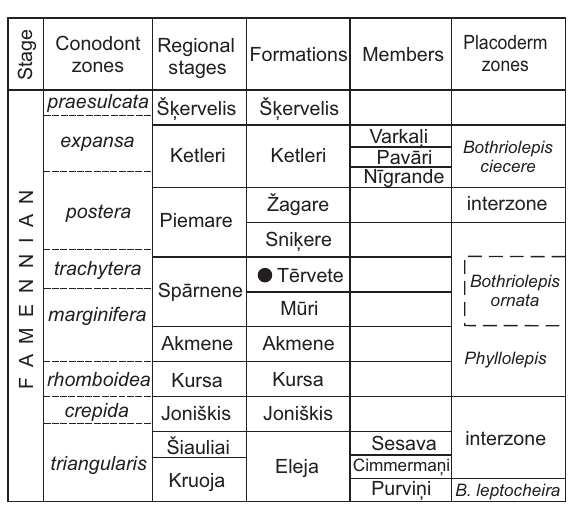
Fig. 2. Stratigraphic chart of the Famennian deposits of Latvia. Modified from Lukševičs et al. (2012) and Lukševičs & Stinkulis (2018). The black circle designates the stratigraphic level of this